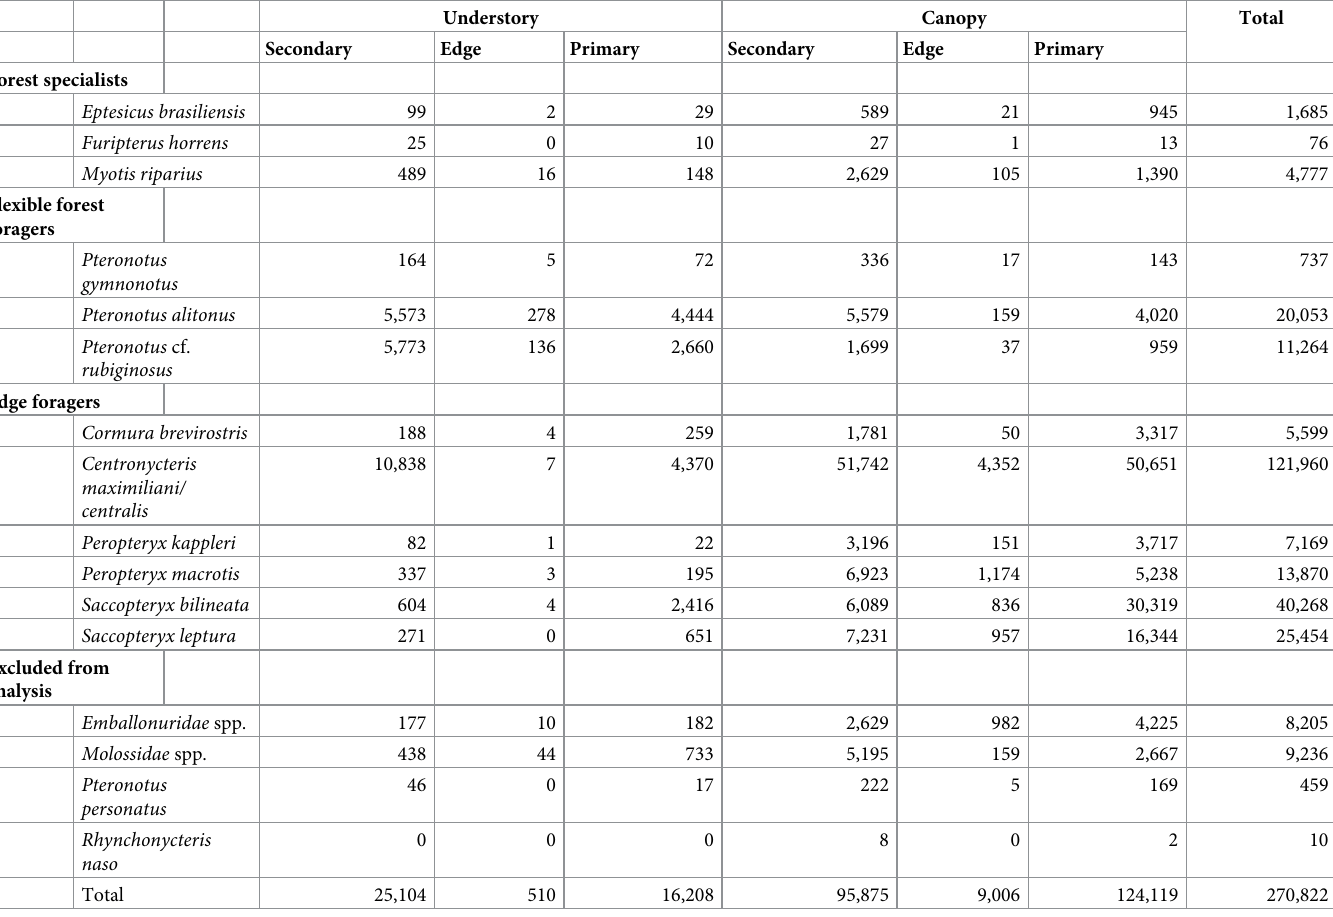
Table 1. Total number of bat passes per species/sonotype in both the understory and canopy of secondary forest, forest edge, and primary forest. Understory Canopy